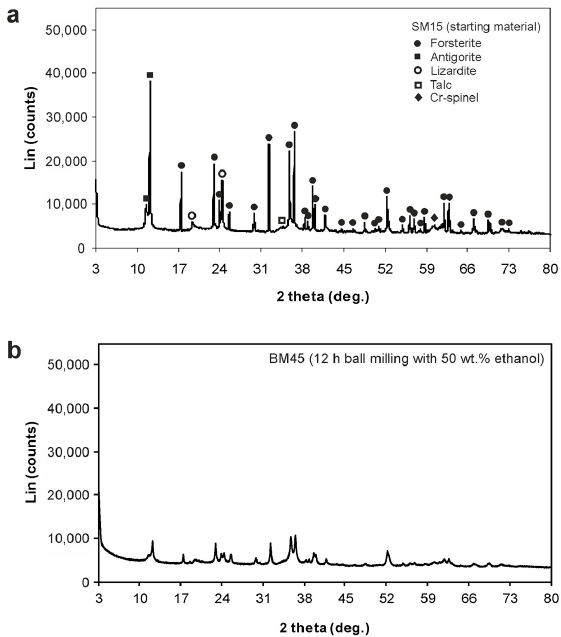
Figure 1. Powder X-ray diffraction patterns of ( a ) unmilled dunite, and ( b ) dunite after 12 h of ball milling with 50 wt% ethanol as PCA (modified from Rigopoulos et al. [19]).